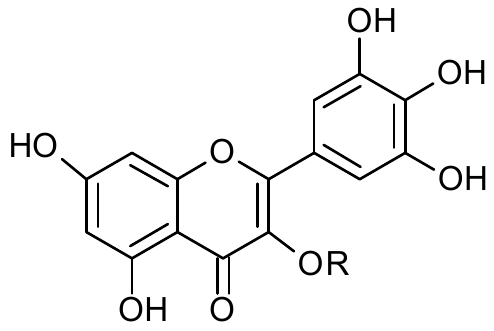
Figure 6. Luteolin and isorhamnetin, and derivatives. Table 3 . Luteolin and isorhamnetin, and derivatives.